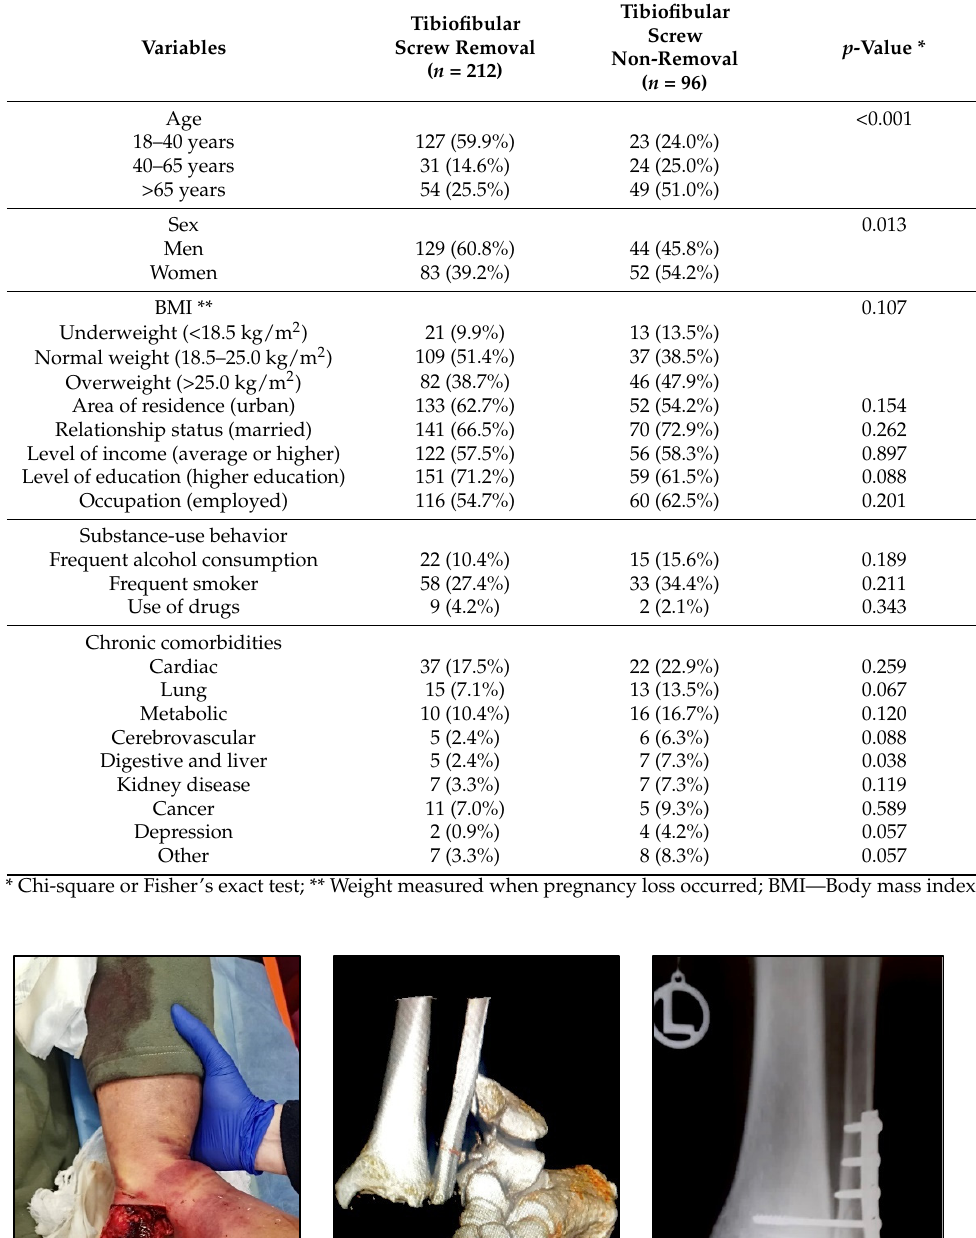
Table 1. Comparison of the study cohort background characteristics.